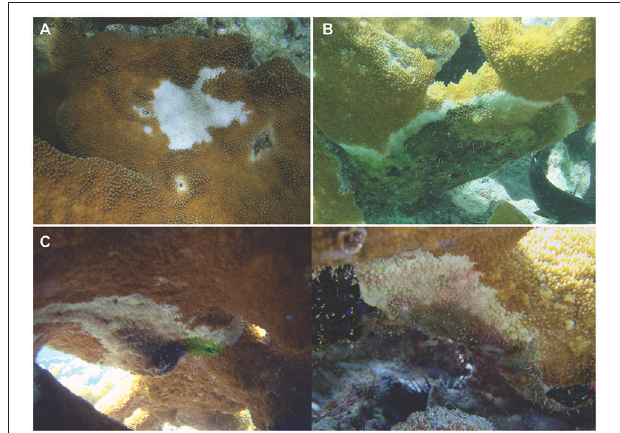
FIGURE 2 | Photo examples for characteristic patterns of tissue loss. (A) white pox disease (B) white band disease (C) overturned syndrome (2